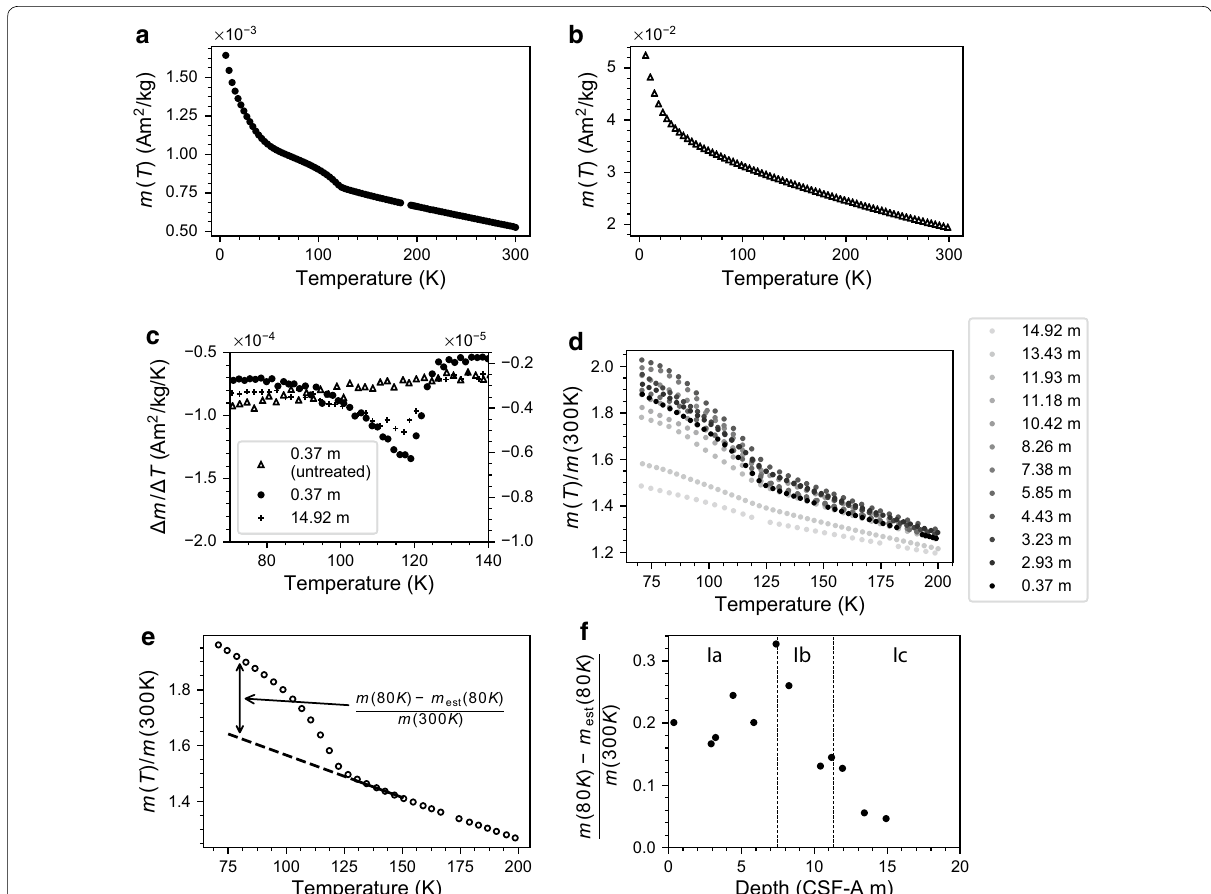
Fig. 7 Low-temperature magnetism. a , b Representative thermal demagnetization of low-temperature remanence normalized by the remanence at 300 K of quartz and feldspars ( a ) and untreated sample ( b ) from 0.37 m. c Temperature derivative of thermal demagnetization around 120 K highlighting the Verwey transition. Open squares represent untreated samples from 0.37 m (left scale). Solid circles and crosses represent quartz and feldspars from 0.37 and 14.92 m, respectively (right scale). d Depth variation of low-temperature demagnetization behavior of the quartz and feldspars around the Verwey transition. e The graphical explanation for quantification of the demagnetization across the Verwey transition. f The demagnetization across the Verwey transition versus depth. Vertical dashed lines represent lithostratigraphic unit